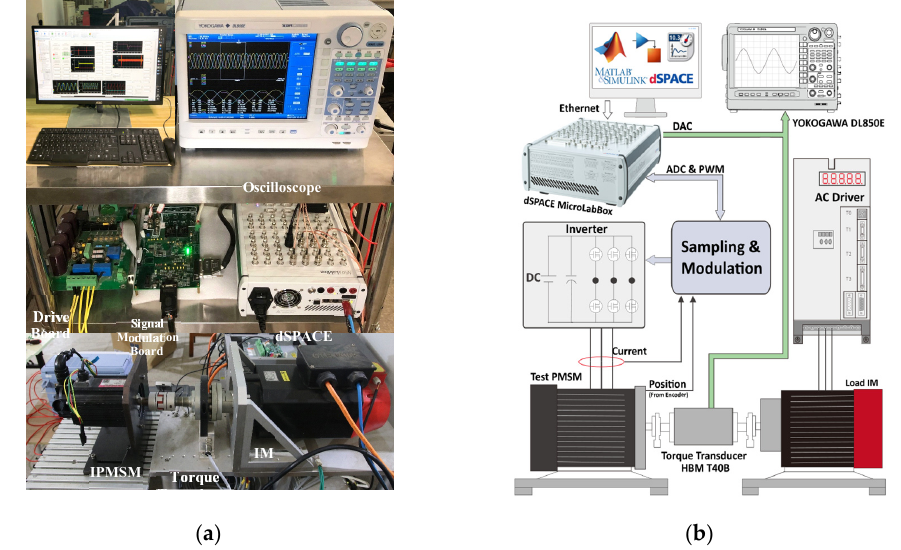
Figure 10. Experimental platform: ( a ) Platform photo. ( b ) Platform diagram. Table 3. IPMSM parameters.